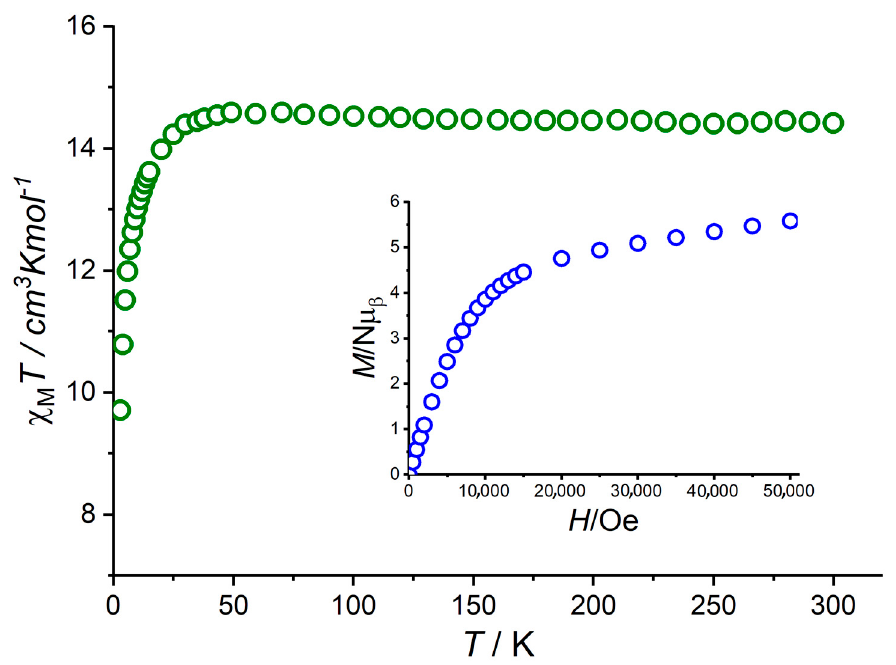
Figure 3. χ M T vs. T graph for 1 . Inset: M /Nµ B vs. H at 2 K.